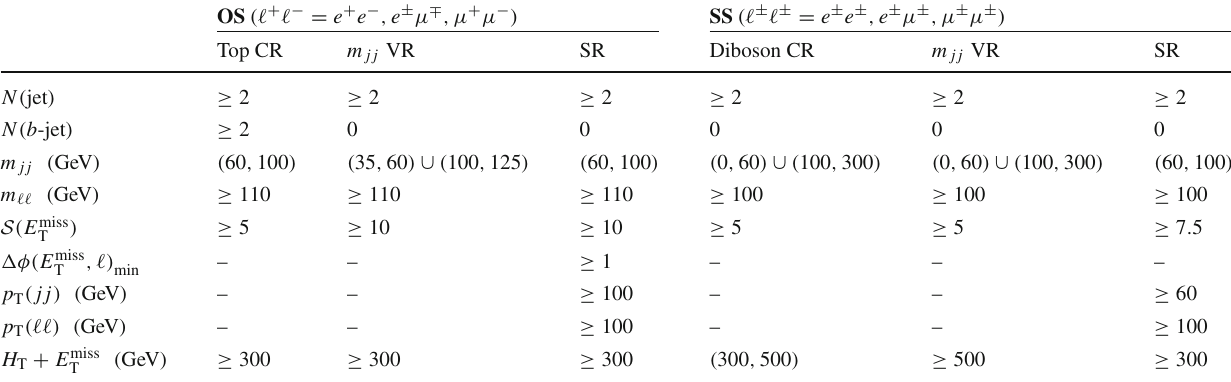
Table 2 A summary of all analysis regions defined in the text. The region definitions are the same for all analysis channel flavour combinations OS ( (cid:5) + (cid:5) − = e + e − , e ± μ ∓ ,μ + μ −